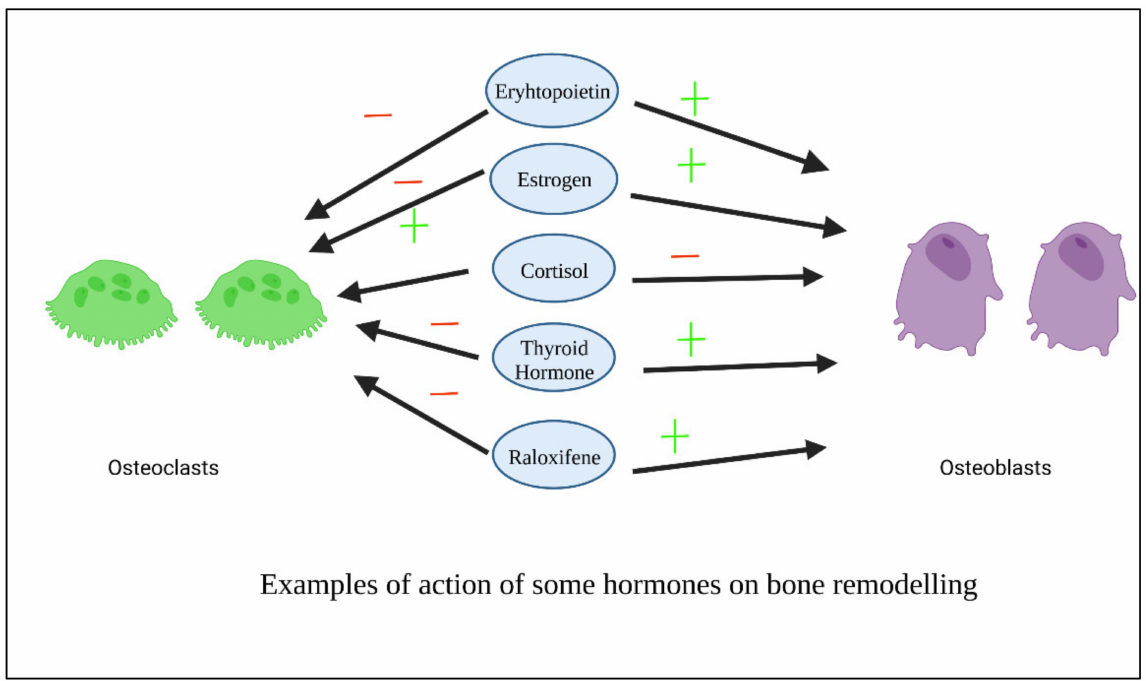
Figure 5. Examples of action of some hormones on osteoblasts.